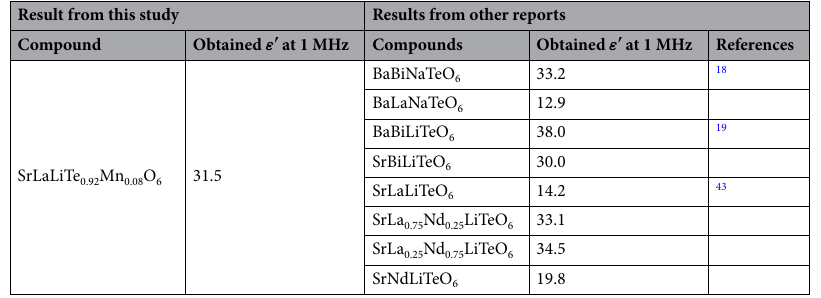
Table 4. The highest values of ε ′ at 1 MHz from our study in comparison with results from other